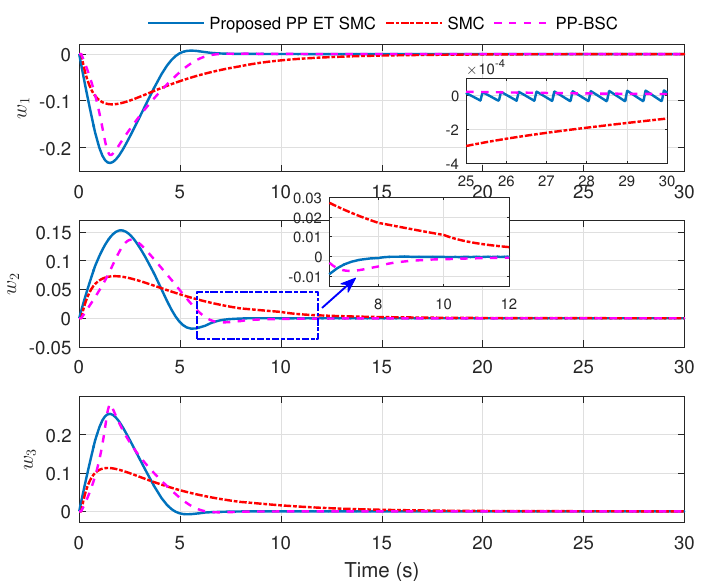
Figure 5. Angular velocity response.